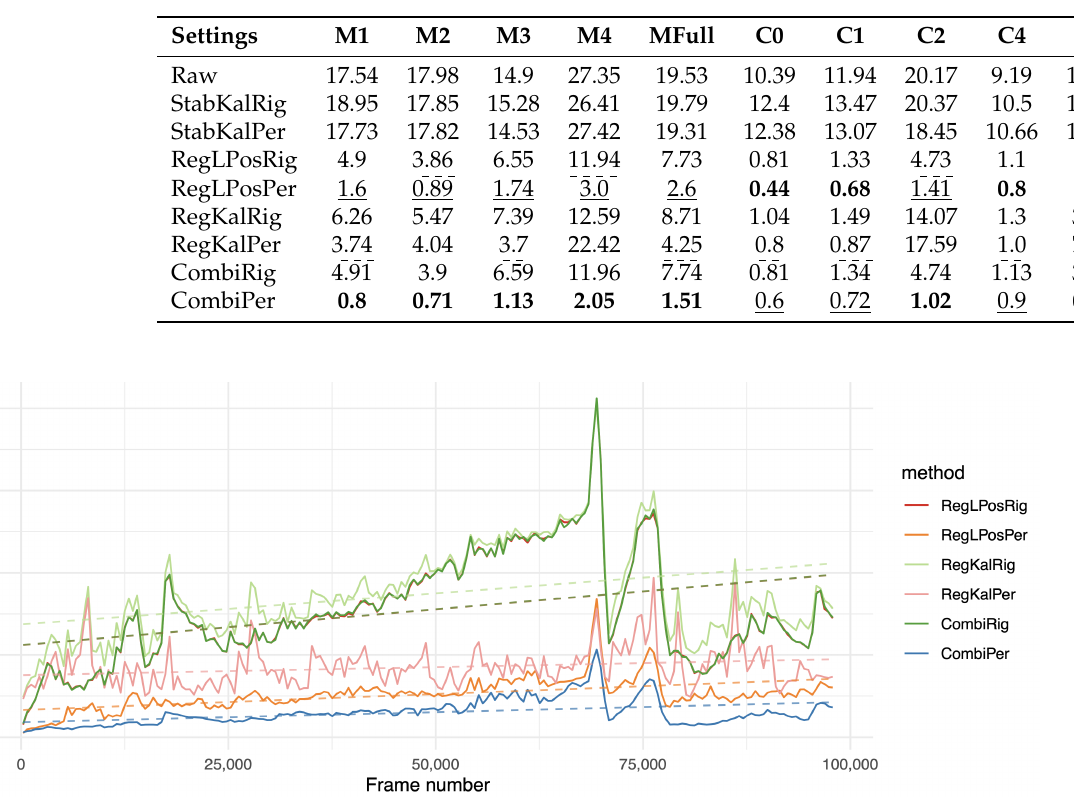
Table 1. Mean frame displacement ( fd ) on our test sequences (pixels). First rank ; second rank;